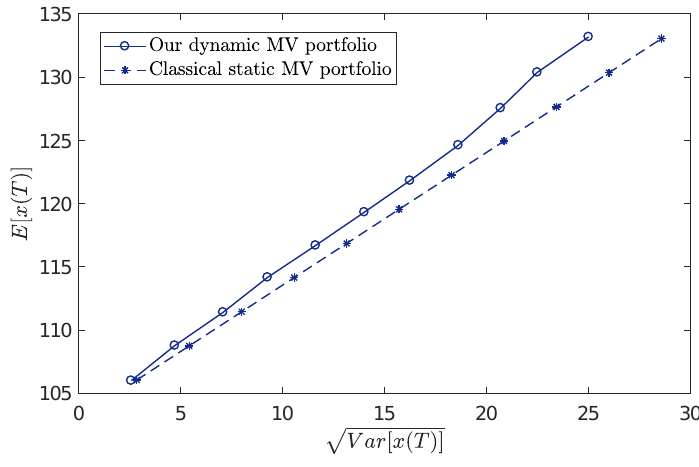
Figure 2. The realized wealth processes.